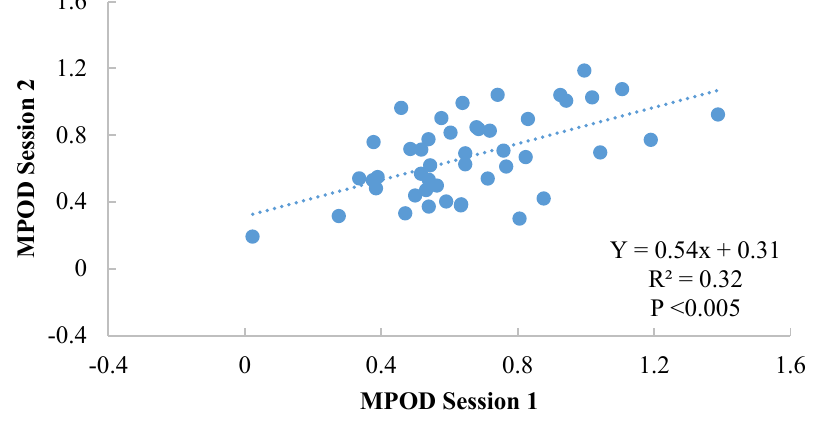
Figure 3. Illustration of the intersession correlation between sessions 1 and 2 for Subgroup 2 (2